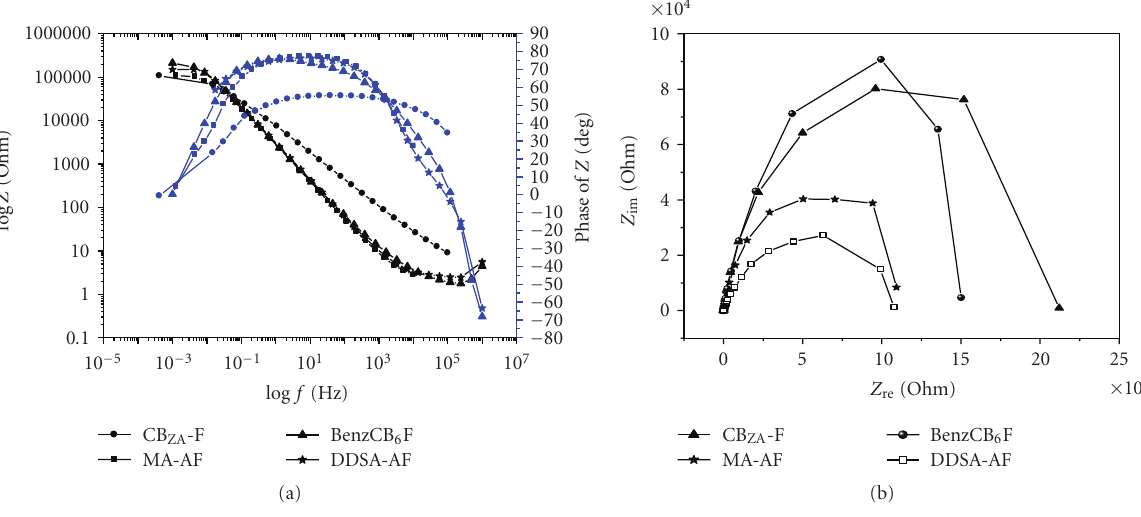
Figure 3: Bode (a) and Nyquist (b) diagram for resin coated SS.